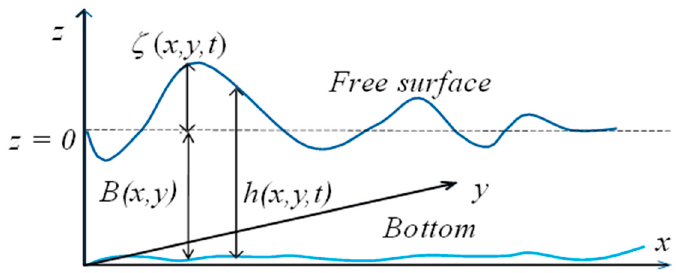
Figure 2. Bathymetry and depth diagram where z is the vertical coordinate, ζ is the wave height, h is the water depth and B ( x , y ) is the lake bathymetry.